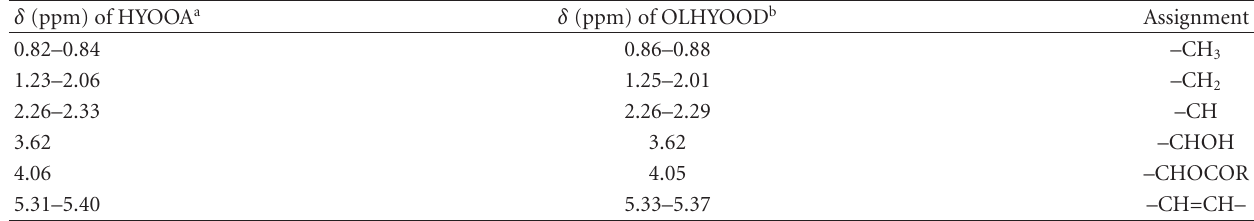
Table 7: The main signals present in 1 H NMR functional groups of HYOOA and OLHYOOD. δ (ppm) of HYOOA a